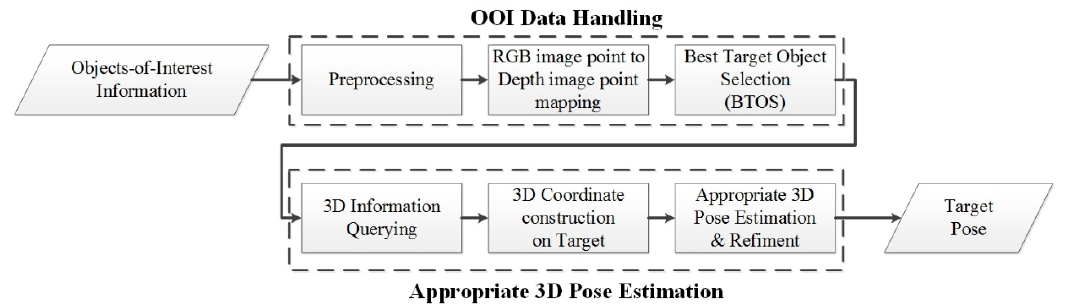
Figure 7. Flowchart of the proposed 3D object pose prediction method.